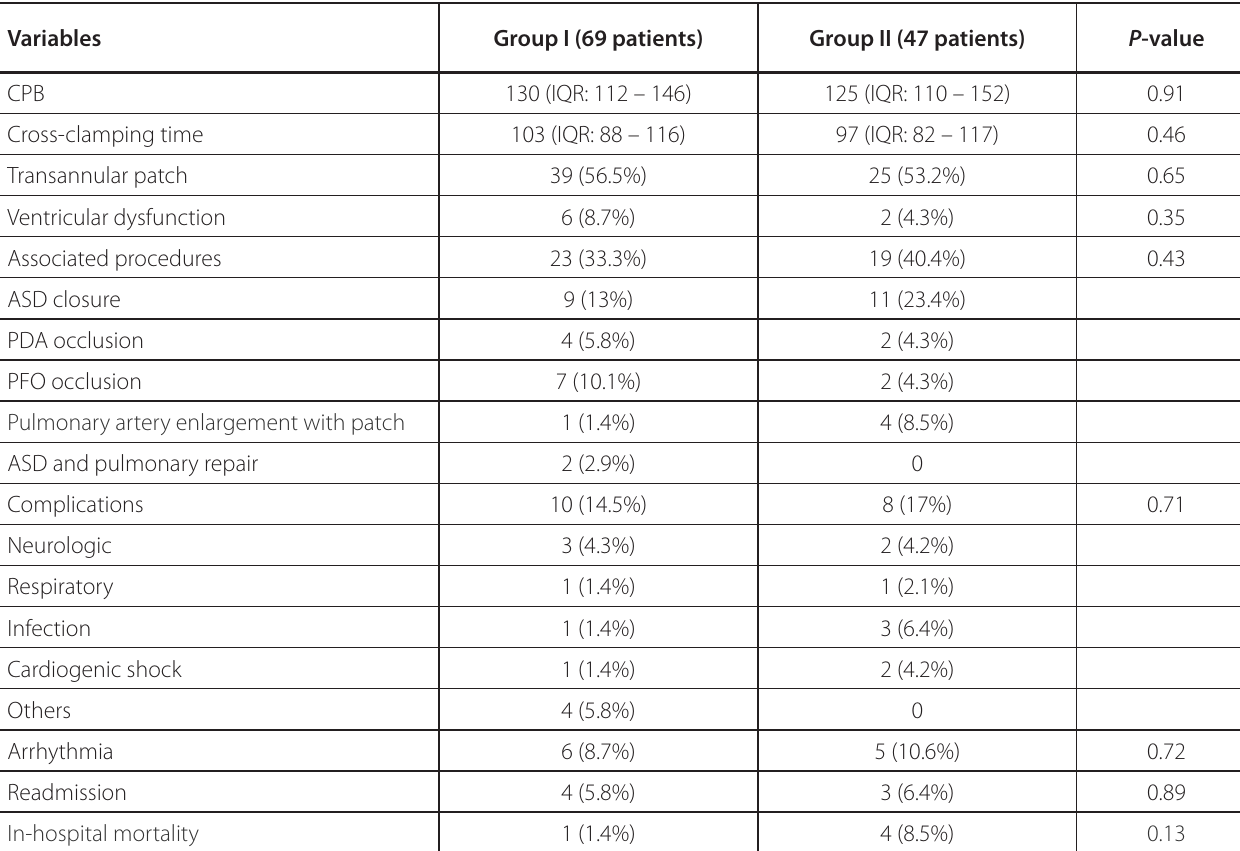
Table 2 . Intraoperative data complications and mortality of surgical correction of 116 patients with tetralogy of Fallot from January 2014 to December